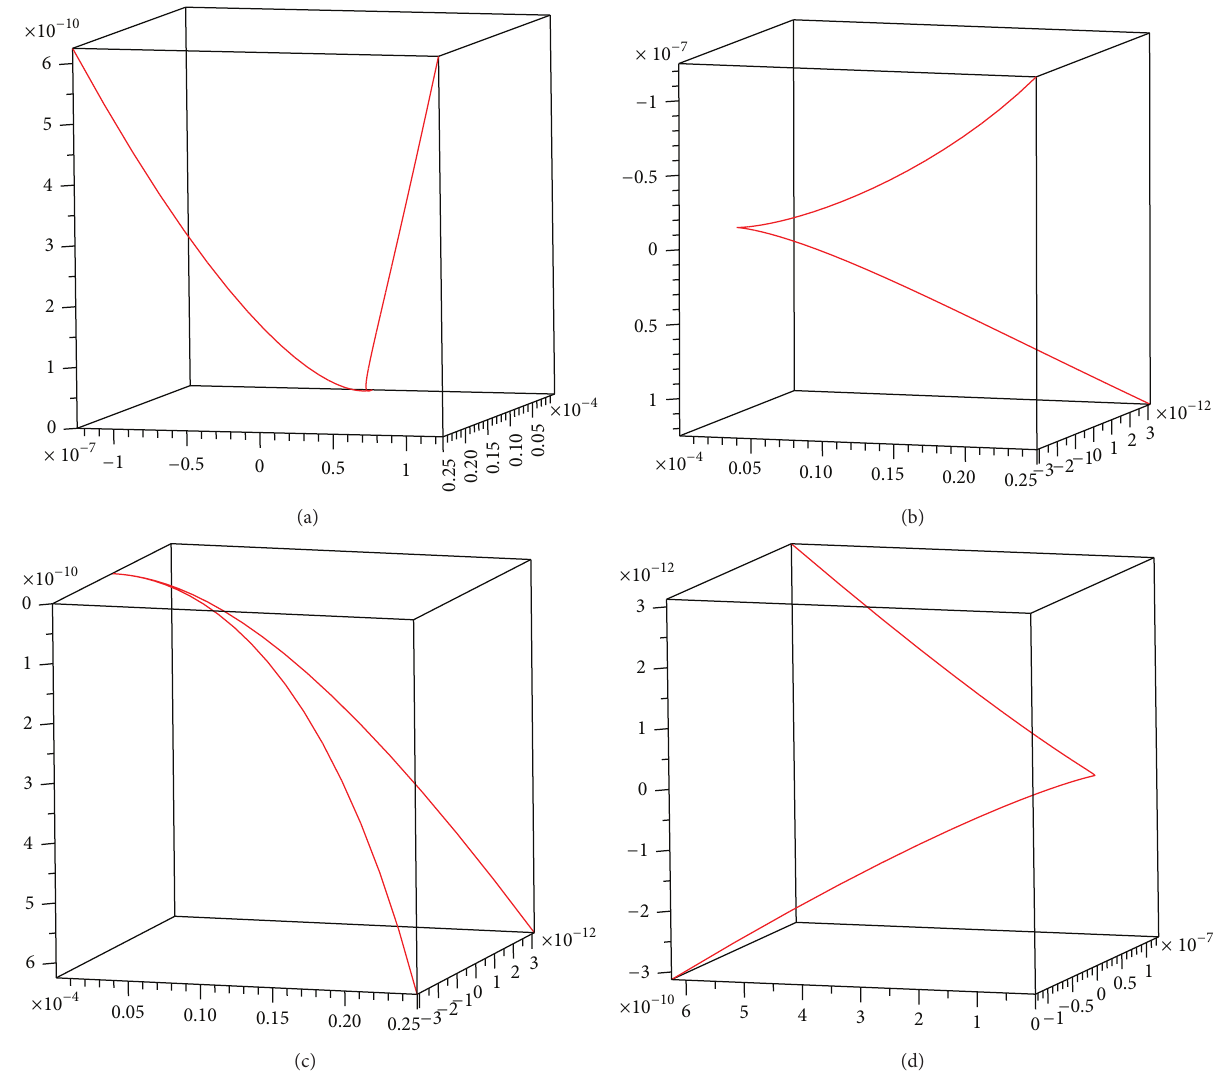
Figure 2: Projection of a (2,3,4,5)-cusp, respectively, on 𝑥 1 𝑥 2 𝑥 3 -space, 𝑥 1 𝑥 2 𝑥 4 -space, 𝑥 1 𝑥 3 𝑥 4 -space, and 𝑥 2 𝑥 3 𝑥 4 -space. an r-parameter unfolding of f , if 𝑓(𝑠) = 𝐹 x has 𝐴 𝑘 -singularity at 𝑠 0 , if 𝑓 (𝑝) (𝑠 0 ) = 0 for all 1 ≤ 𝑝 ≤ 𝑘 and ) ̸= 0 . Let 𝐹 be an 𝑟 -parameter unfolding of 𝑓 and 𝑓 𝑓 (𝑘+1) (𝑠 0 has 𝐴 𝑘 -singularity (𝑘 ≥ 1) at 𝑠 0 . We denote the (𝑘 − 1) -jet of the partial derivative 𝜕𝐹/𝜕𝑥 𝑖 at 𝑠 0 by